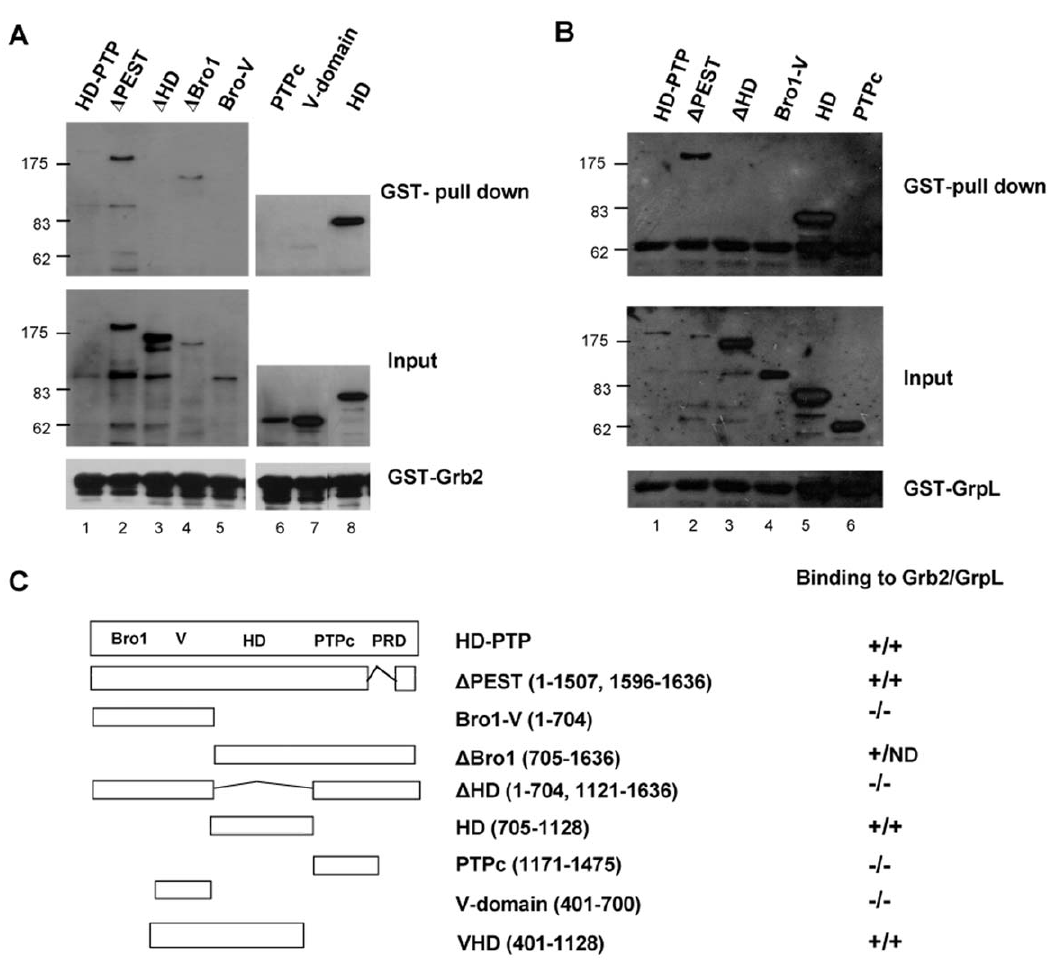
Figure 4. HD-PTP binds Grb2 and GrpL via its Histidine Domain. Lysates from HEK293T cells transfected with EGFP-HD-PTP were pulled- down with either GST-Grb2 (A), or GST-GrpL (B). Immunoblots for the pulled-down fractions, probed with anti-GFP antibodies are shown, along with the total lysates to demonstrate protein expression. Input represents 20% of each lysate used for pull-down. The figure shown is representative for experiments repeated at least twice with similar results. (C) Schematic overview of the HD-PTP constructs and the summary of the GST pull-down and GST overlay assays. PRD-proline-rich domain; ND-not determined. doi:10.1371/journal.pone.0014339.g004 PLoS ONE |